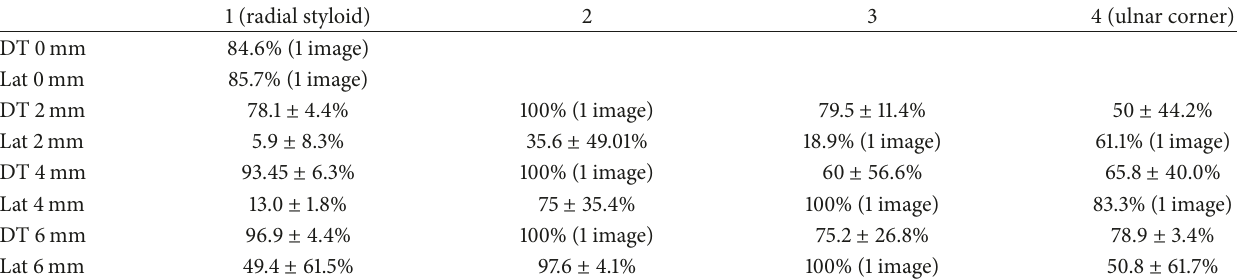
Table 3: Overall accuracy based on imaging technique and screw position and degree of